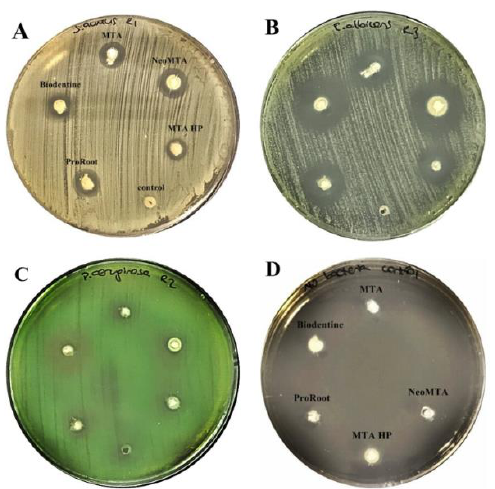
Figure 1. Zone of inhibition of five calcium silicate-based cements at 24h against ( A ) S . aureus , ( B ) C . albicans , ( C ) P . aeruginosa , ( D ) No bacteria/control.